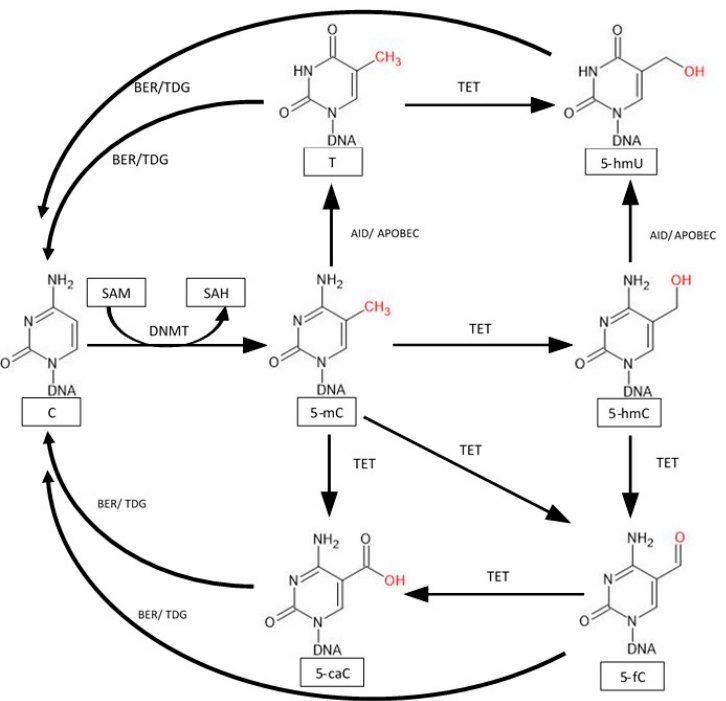
Figure 4. Modification of 5-methylcytosine leads to the restoration of unmethylated cytosine. 5-mC is oxidized by TET protein to 5-hmC, 5-formylcytosine (5-fc), and 5-carboxylcytosine (5caC). Thy- mine (T) can also be oxidized by TET to 5-Hydroxyuracil (5-hmU). Deamination of 5-mC and 5-hmC by an enzyme complex Activation-induced deaminase/apolipoprotein B mRNA-editing catalytic polypeptide-like (ADI/APOBEC) leads to the formation of thymine and 5-hmU. The final step in restoring cytosine occurs with Base Excision Repair (BER) and thymine DNA glycosylase (TDG), which modify 5-fc, 5-caC, 5-hmU, and T [76–80]. Exercise and aging can also affect TET protein expression. TET protein expression decreases over time, and exercise is able to stop these changes. An effect was seen in the hippocampus of old rats, but not in the hypothalamus [79]. A decrease in TET1 expres- sion under the influence of exercise was observed in arterial myocytes of rats [80]. The involvement of TET family proteins in exercise-induced demethylation is a little explored topic, but several studies show that there is a modification of the expression of these genes. 6. Summary Accurate determination of the effects of DNA methylation on individual genes and globally is problematic in some cases. Comparing global methylation across studies presents a problem due to different techniques for determining this level. Some of them appear to be less precise, such as the LUMA test. Moreover, the use of a different matrix makes it possible to detect or omit sites of altered methylation that were recognized in other research protocols [39]. A direct example of potential mistakes was presented by Lindholm et al., who observed increased methylation after exercising two CpG sites, as in the work of Nitert et al. The difference was in the location of the modified nucleotides, because the first noticed this change in the gene’s body, and the second in the promoter region, which may already affect transcriptions [33].